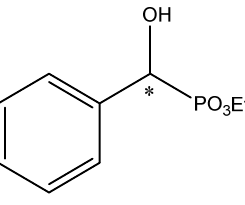
Figure 8. Racemic mixture of diethyl 1-hydroxy-1-phenylmethanephosphonate. Based on [98] with permission.